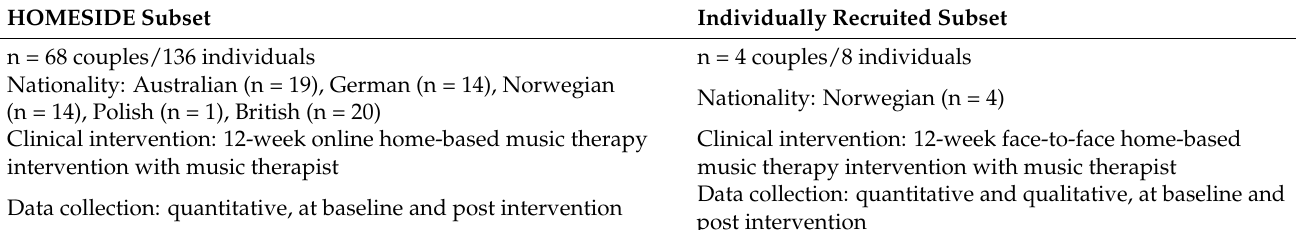
Table 1. Participant